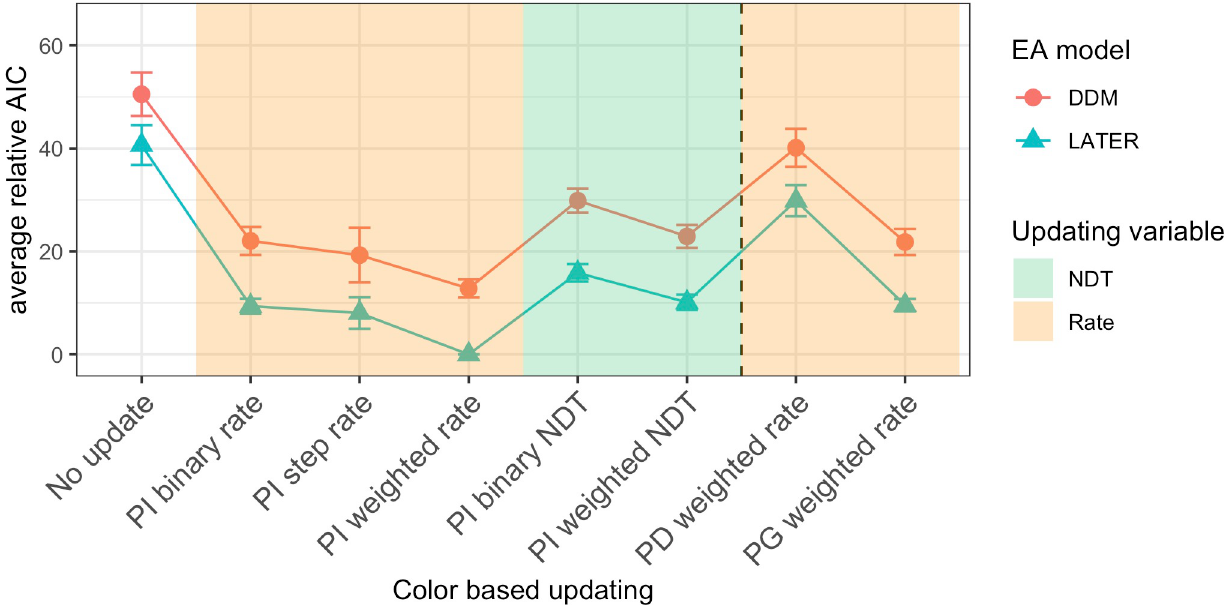
Fig 5. Model comparison for color-based updating. Mean relative AIC for all different color-based updating rules when using the best updating rules for response-critical feature (RCF) and position. The dashed vertical line separates rules that update based on color alone (left) and rules that also take the target position into account (right). The different background colors mark rules that update either the rate (orange) or the non-decision time (green). Error bars represent the standard error of the mean over participants and sessions. PI: position-independent; PD: full position-dependent; PG: a gradient- like dependence on the change of position; NDT: Non-decision